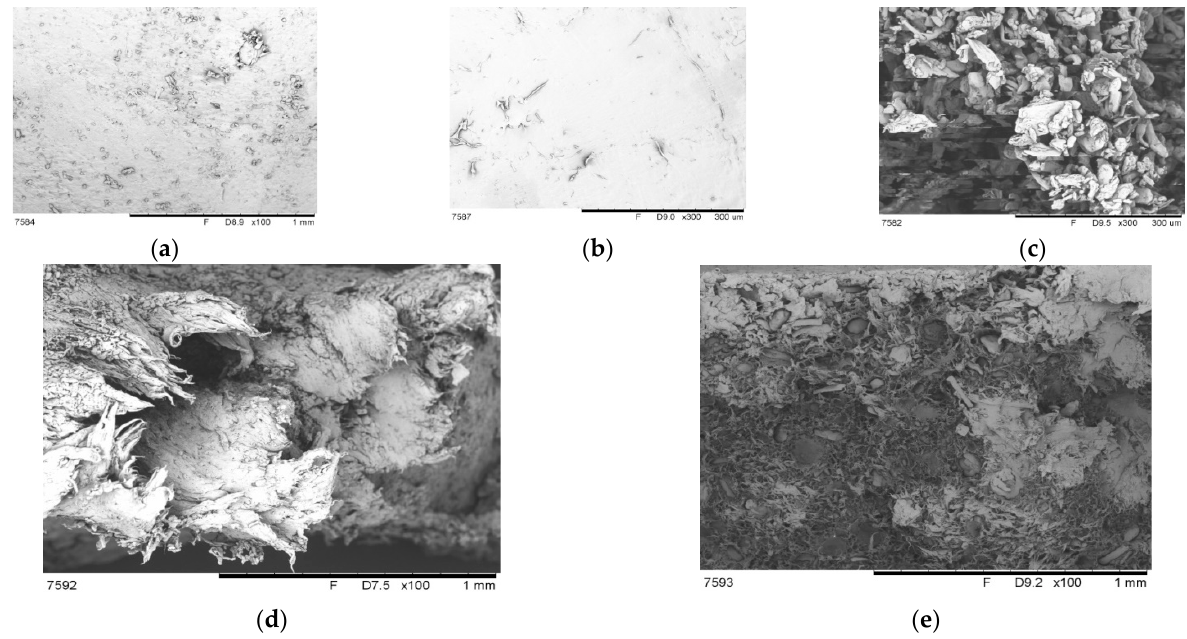
Figure 3. SEM micrographs of the surface of ( a ) TPS, ( b ) PBAT, ( c ) MCC, and the fracture surfaces of the samples with ( d ) 2% MCC and ( e ) 8%